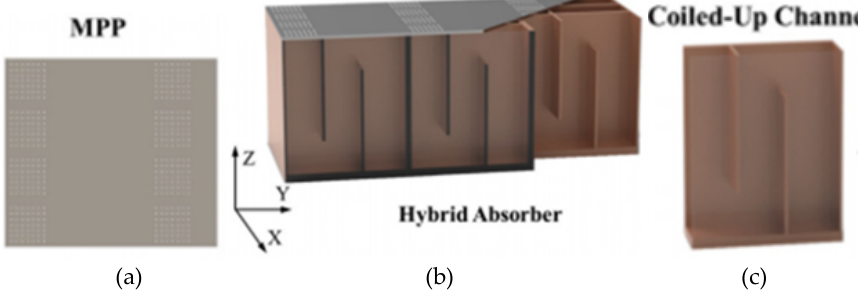
Figure 16. Schematic diagram of proposed structure: ( a ) The top micro-perforated panel; ( b ) Schematic of the hybrid metamaterial absorber; ( c ) Diagram of one coiled-up FP channel [57].